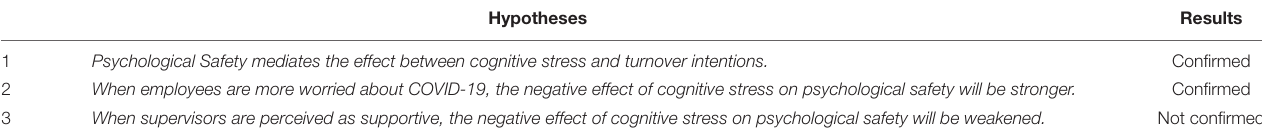
TABLE 5 | Summary of hypotheses and results. Hypotheses